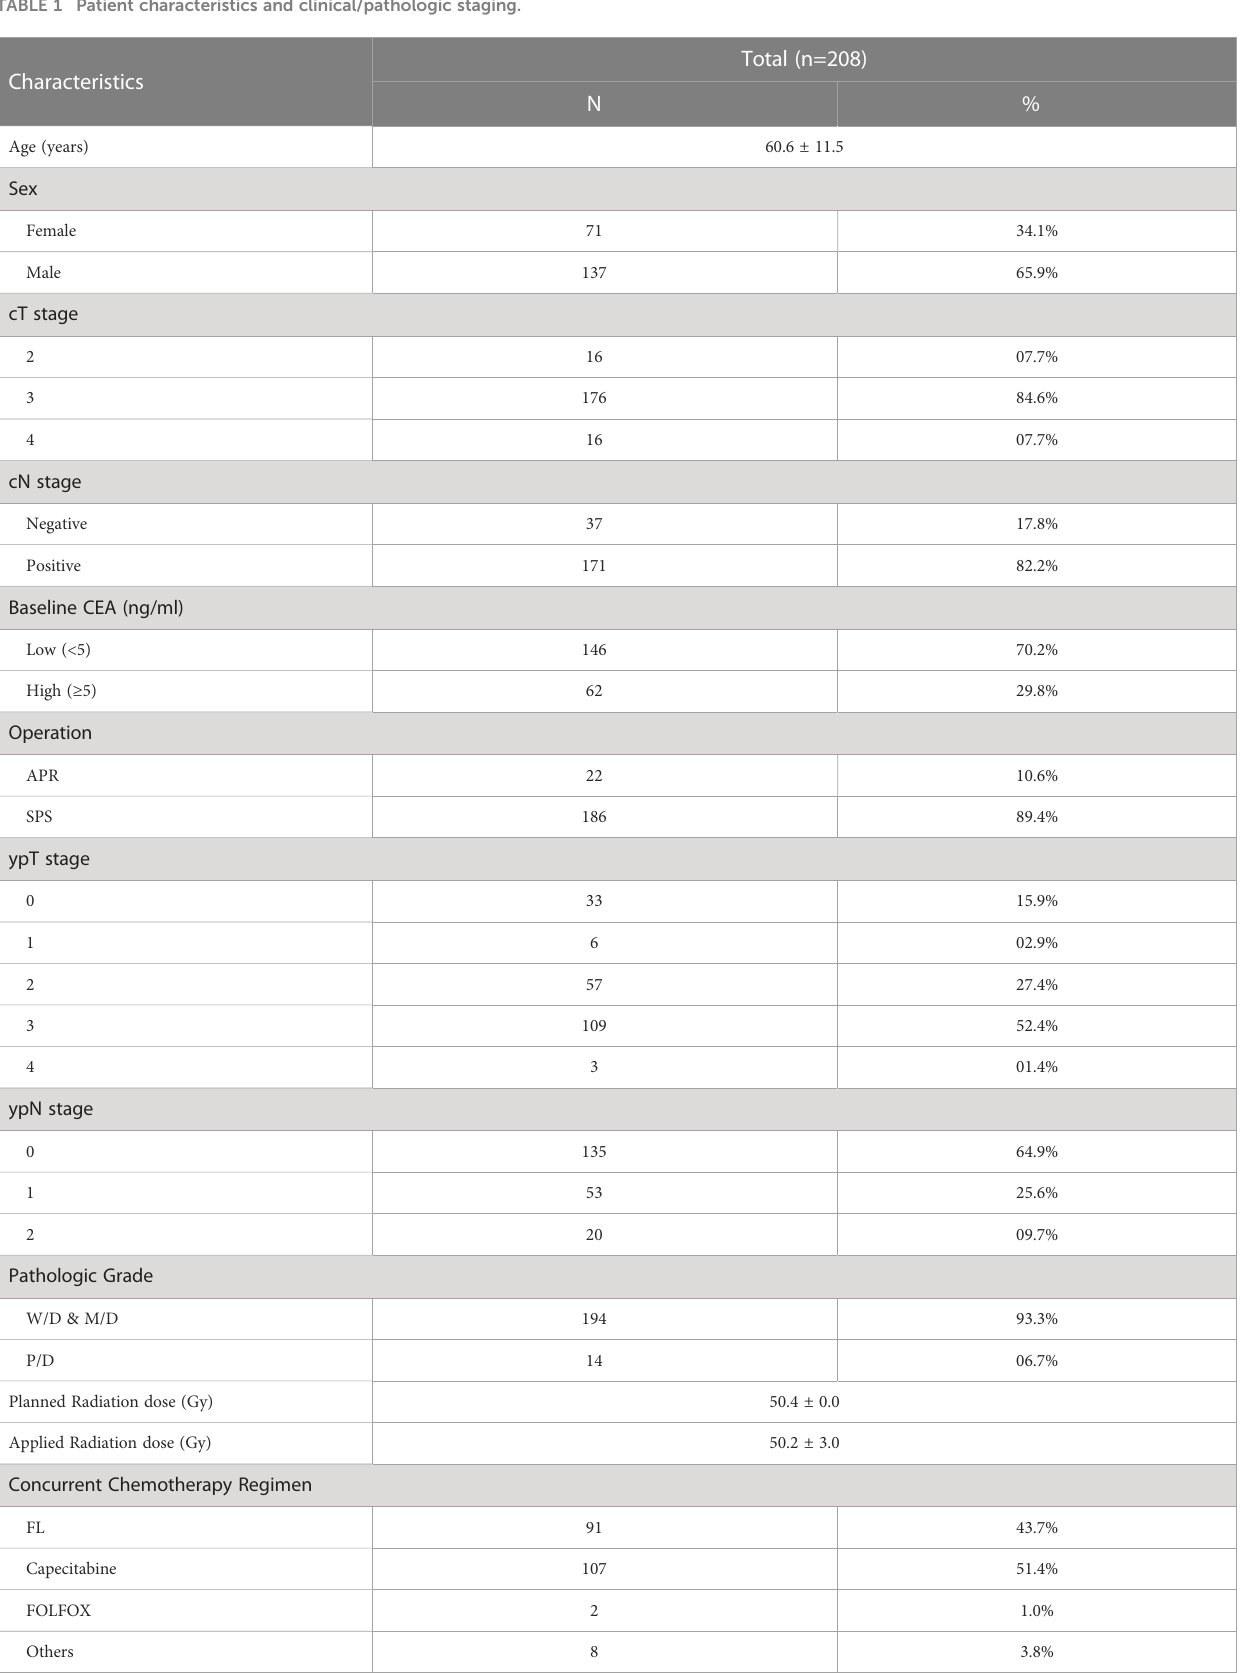
TABLE 1 Patient characteristics and clinical/pathologic